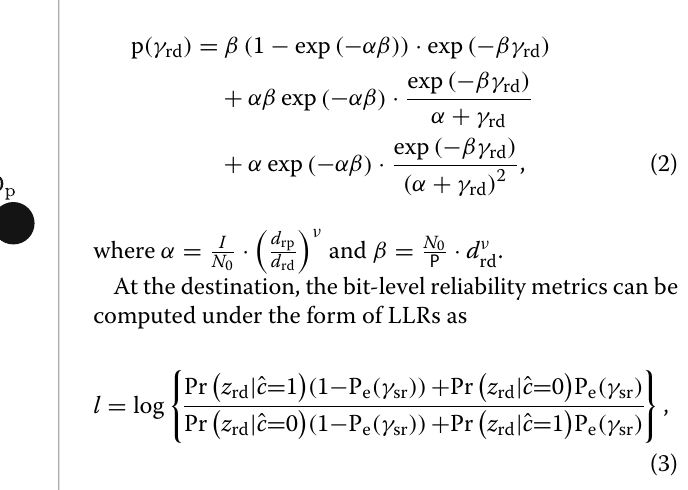
Fig. 1 System model of an underlay dual-hop system, where S s , R s , D s , and D p denote the secondary source, secondary relay, secondary destination, and the primary destination,